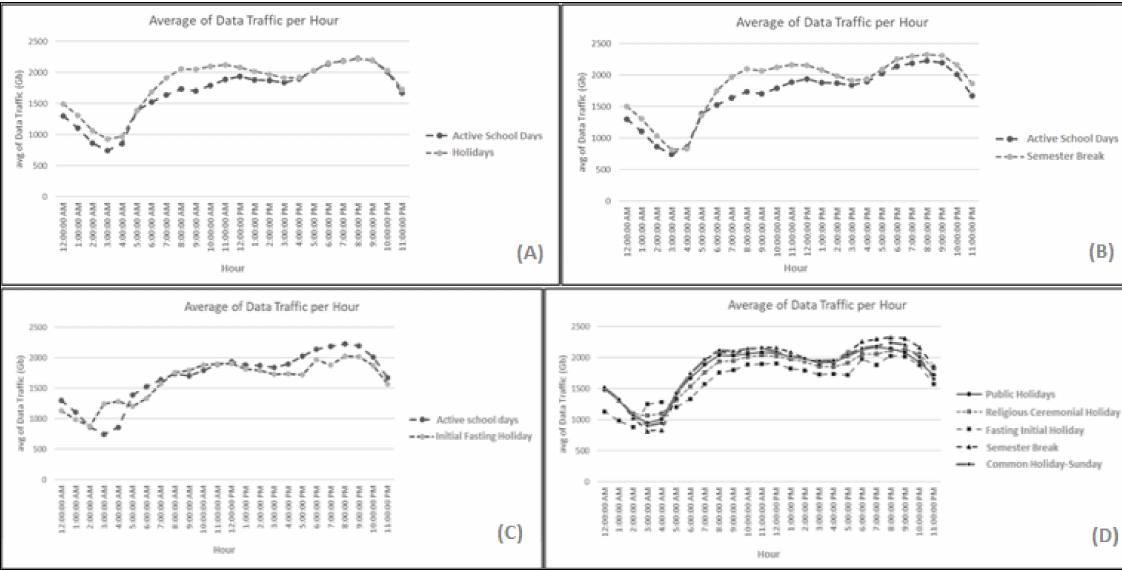
Fig. 9 Trends and patterns of The Internet use (A) School Active Days and all type of School Holidays, (B) School active days and semester break, (C) School active days and Initial fasting holiday, (D) all types of school